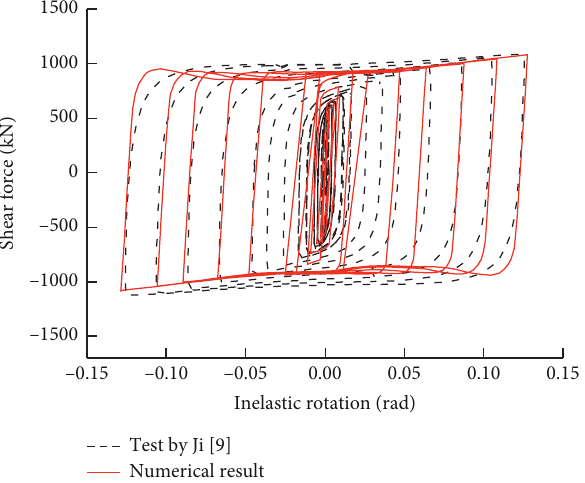
Figure 4: Shear forces versus inelastic rotation for Q11.